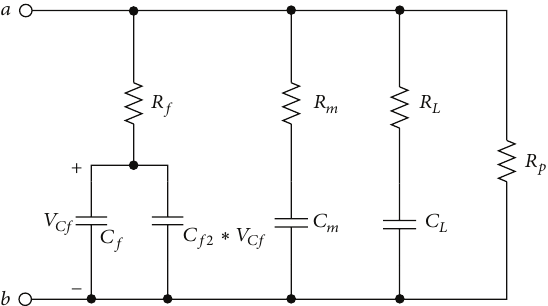
Figure 3: Equivalent circuit developed by Zubieta and Bonert.